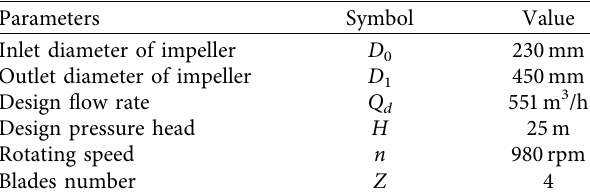
Figure 1: 3D model of the centrifugal pump. Table 1: Geometric parameters of centrifugal pump.